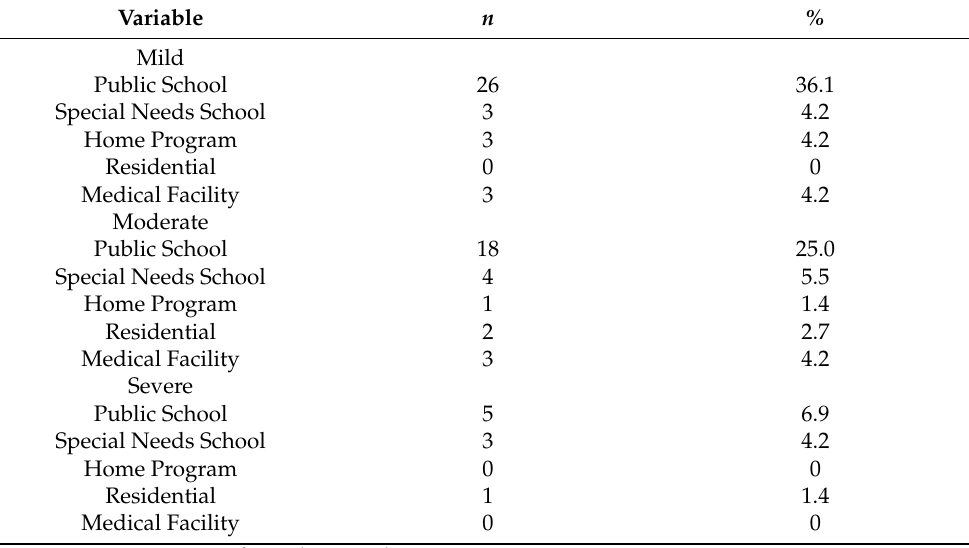
Table 2. School Placement Based on Diagnostic Severity